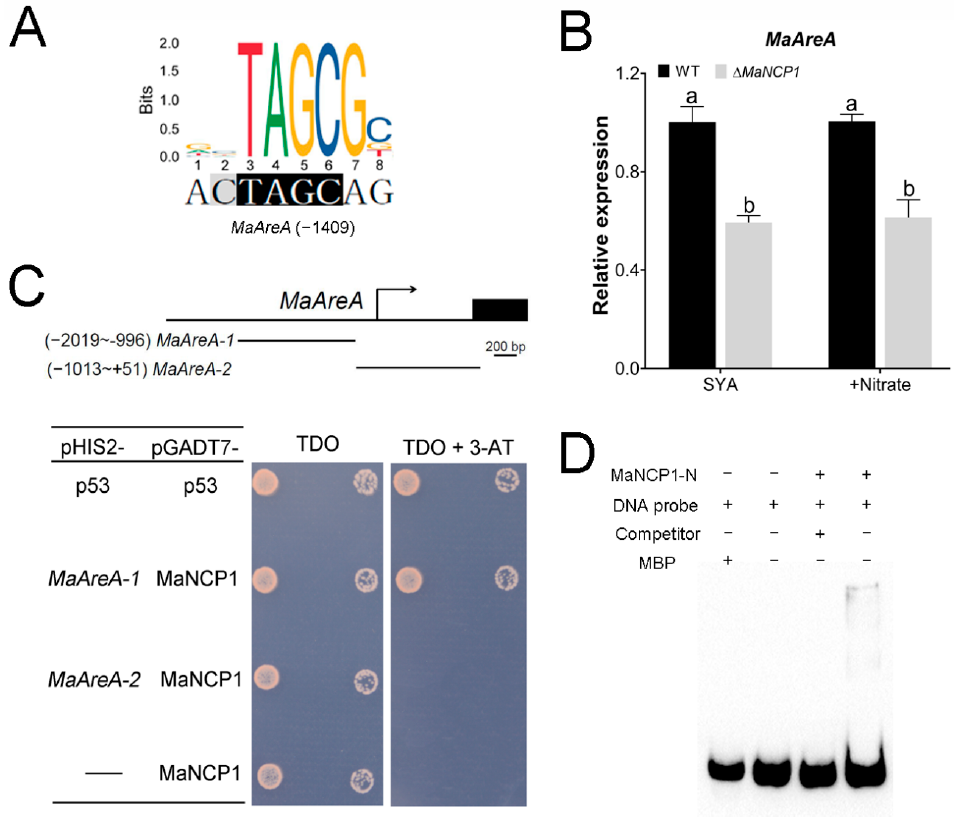
Figure 4. MaAreA is a target gene of MaNCP1. ( A ) Putative binding site prediction of MaNCP1. The potential cis-element was identified via JASPAR 2020 database [33]. ( B ) Transcription level analysis of MaAreA . Fungal strains were spread on SYA or SYA+N media and cultured at 28 °C for 18 h. Lowercase letters indicate significant difference at p < 0.05 (T-text). ( C ) Yeast one-hybrid assay. TDO, SD/-Leu/-Trp/-His. The concentration of 3-AT was 8 mM. ( D ) The EMSA analysis. MBP, MBP-tag protein. MaNCP1-N, the N-terminal of MaNCP1 protein. Competitor, the unlabeled probe, which was added in a 100-fold excess. +, probe or protein added, － , probe or protein not added.